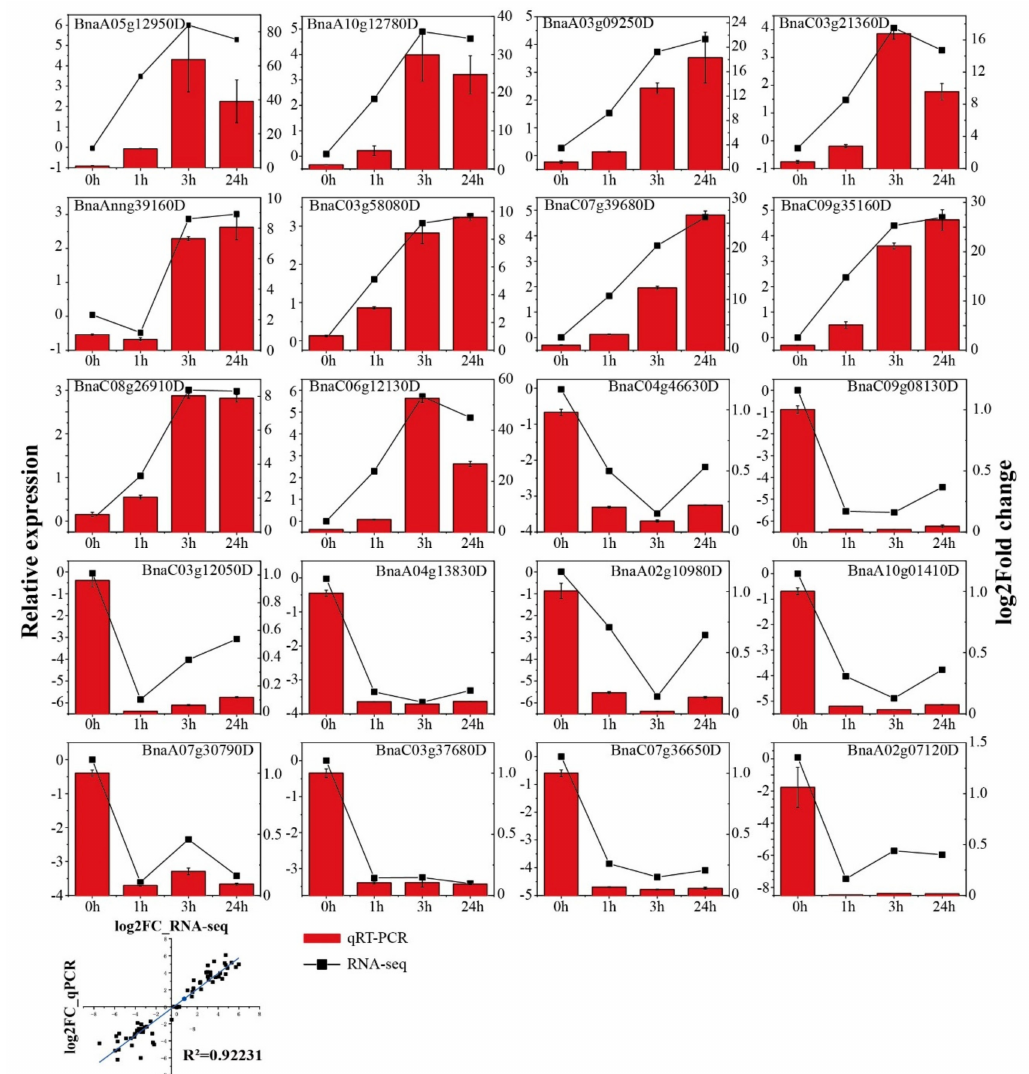
Figure 7. The qRT-PCR analysis of selected DEG genes in Brassica napus leaves under the freezing treatment. Error bars represent standard errors of the relative expression levels mean values by qRT-PCR ( n = 4) (left y-axis). Broken lines represent transcript levels change (log2 FC) according to the FPKM value of RNA-Seq (right y-axis). Correlation between qRT-PCR and RNA-seq for select DEGs is also